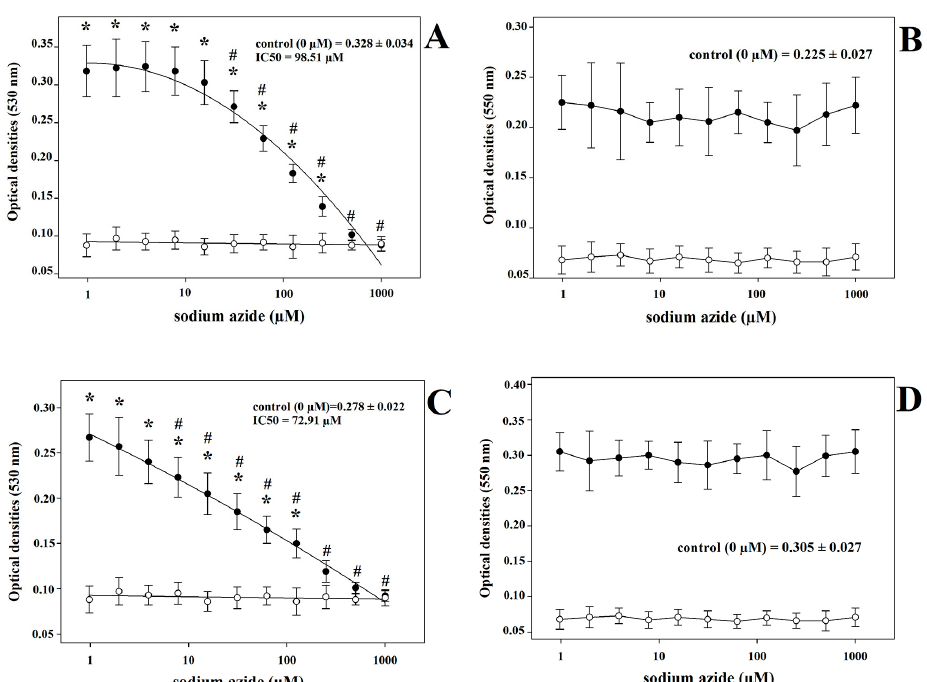
Figure 3. Dose-dependent effects of sodium azide treatment in goat kid ( A , B ) and lamb ( C , D ) blood serum samples, as assessed using ROMs and TOS assays, respectively. Blank abs: optical densities of blank wells treated with the same sodium azide concentrations as the blood serum samples. Mean values with the superscripts # and * show statistically significant differences in comparison with the lowest (0 μ M) and the highest (1000 μ M) sodium azide concentrations, respectively.